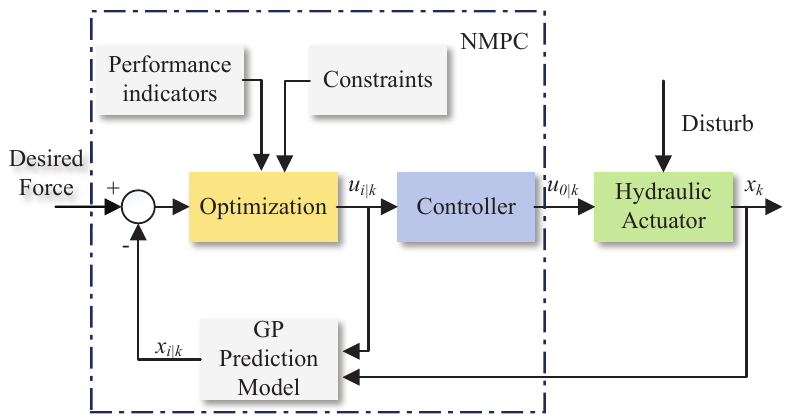
Figure 3. The force control loop of hydraulic system based on LB-NMPC. The Gaussian process is used to correct the model mismatch online. Due to the enormous computational complexity it brings, we use a support vector machine to approximate the NMPC control